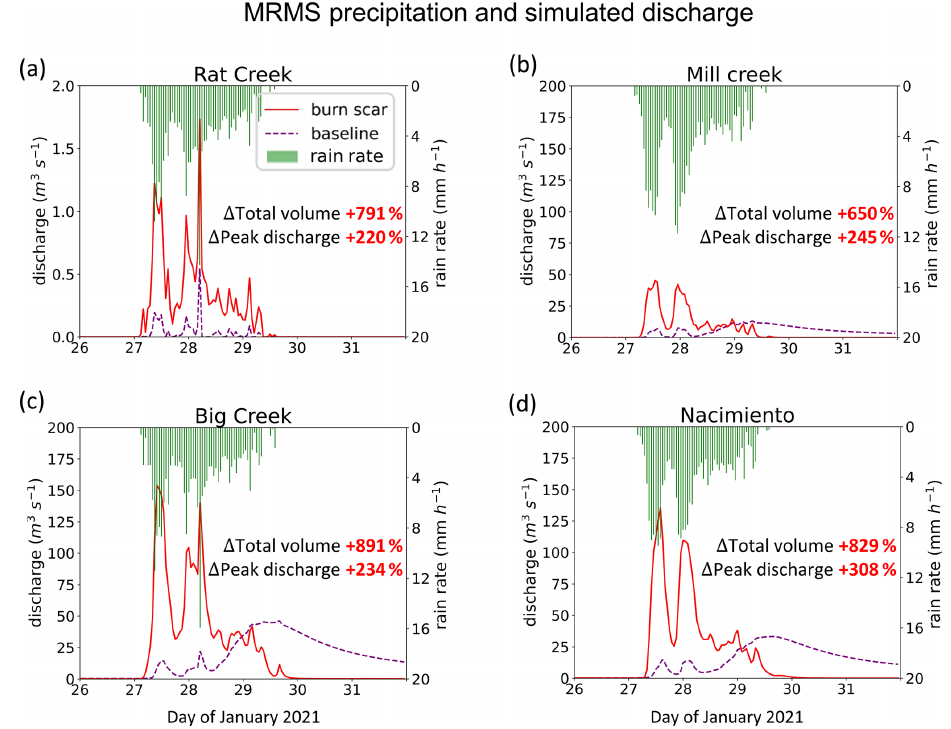
Figure 8. WRF-Hydro-simulated discharge time series at four debris flow deposition locations. (a–d) MRMS precipitation (mmh − 1 ; green bars) and simulated discharge time series for 26 January 00:00 to 31 January 23:00 at (a) Rat Creek, (b) Mill Creek, (c) Big Creek, and (d) Nacimiento deposition locations (black triangles in Fig. 7a–d) in the baseline (m 3 s − 1 ; dashed purple line) and burn scar simulations (m 3 s − 1 ; red